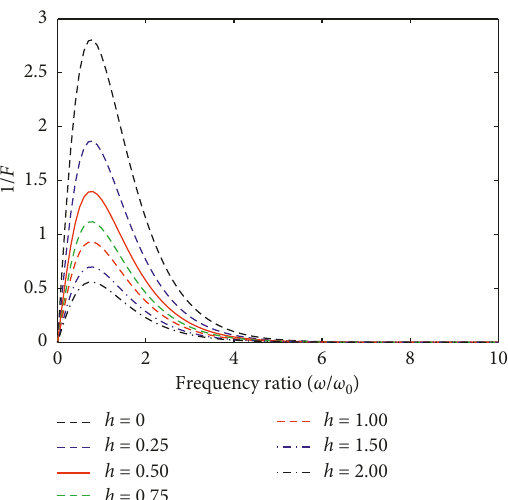
Figure 17: Chaotic threshold curve with different p values ( m � 1, k 1 � 1, c 1 � 0.5, k 3 � 1, and h � 0.5).